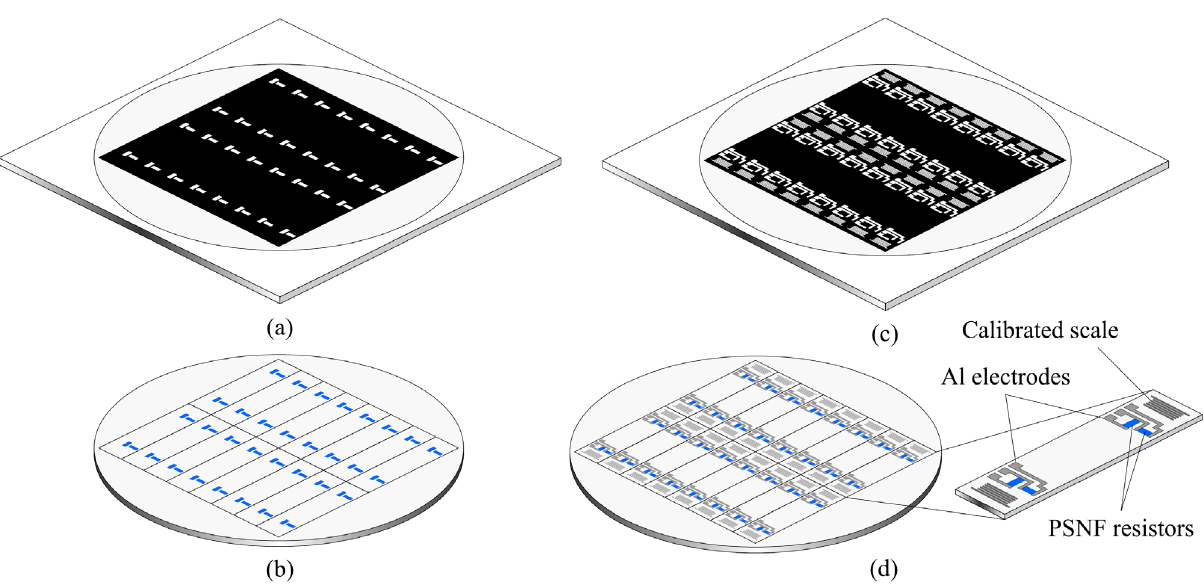
Figure 3. Schematic diagram of mask plates and sample wafers in the fabrication of cantilever beams. (a) The mask plate for patterning resistors. (b) The sample wafer after patterning resistors. (c) The mask plate for patterning electrodes and calibrated scales. (d) The sample wafer and the cantilever beam after fabricating electrodes and calibrated